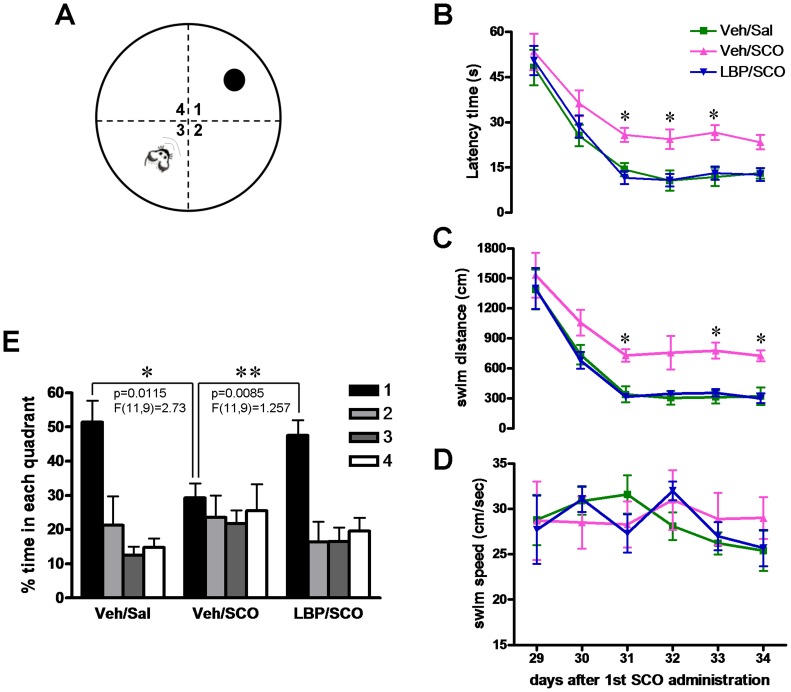
LBP treatment reverses the SCO-induced increase in latency time in the Morris water maze.(A) The apparatus for Morris water maze. The black circle in the northeast quadrant represents the location of the hidden platform. Animals were introduced into the southwest quadrant. (B) The latency time, swim distance and swim speed to find the submerged platform were recorded over six consecutive days. The animals of three groups have the similar swim speed, but SCO treatment (vehicle/SCO group) increased the latency and swim distance to find the hidden platform whereas LBP administration (LBP/SCO group) restored latency and distance to the levels of the vehicle/saline control group. (E) The percentage of time spent in 4 quadrants during the probe trial. The animals in control and LBP/SCO groups spent more time in the target quadrant while SCO treatment decreased time in target quadrant. Values are means ± SEM (Vehicle/saline, n = 12; vehicle/SCO, n = 10; LBP/SCO, n = 11); *,P<0.05 versus the vehicle/SCO group.